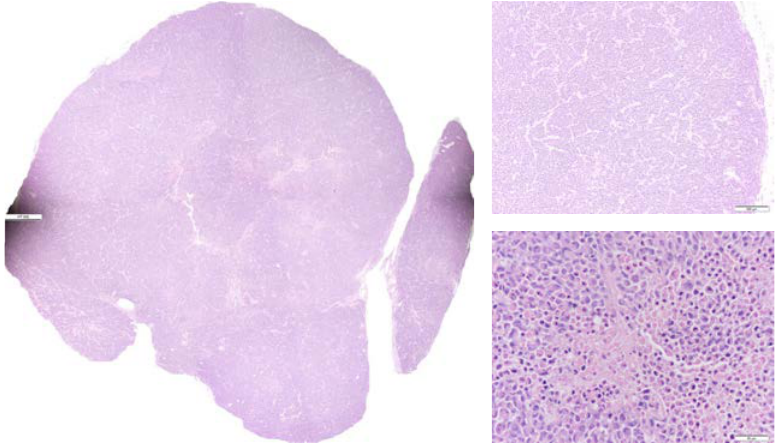
Fig. 5. H&E staining for the p53 wt tumor in Fig. 2. Photo-stitched whole tissue section (L), typical tumor rim (top right, 10X) and typical tumor center (bottom right, 40X).